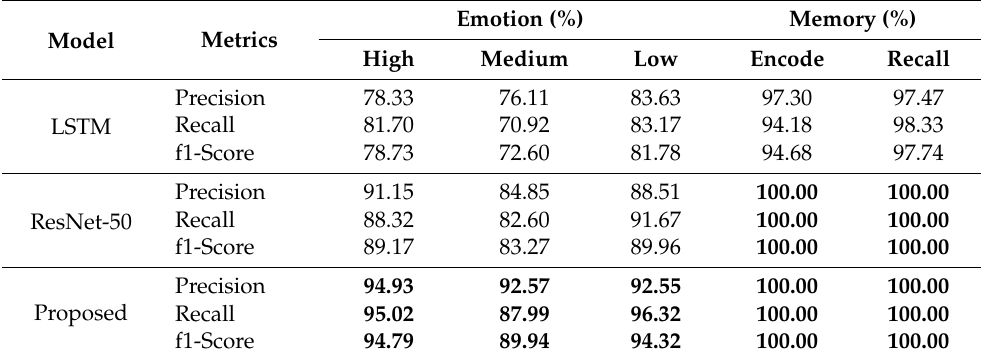
Table 3. Classification performances of models for emotion and memory phase classification experiments.